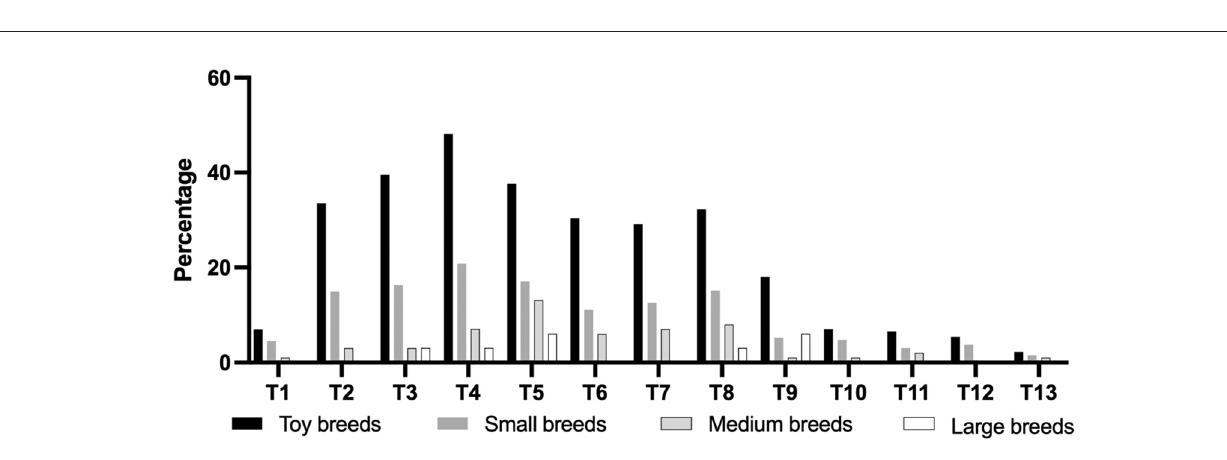
FIGURE4 Percentage of anatomic localization of caudal articular process dysplasia between groups according to breed types classified by weight. Toy breeds, < 5kg; Small breeds, ≥ 5kg, and < 10kg; Medium breeds, ≥ 10kg and < 25kg; Large breeds, ≥